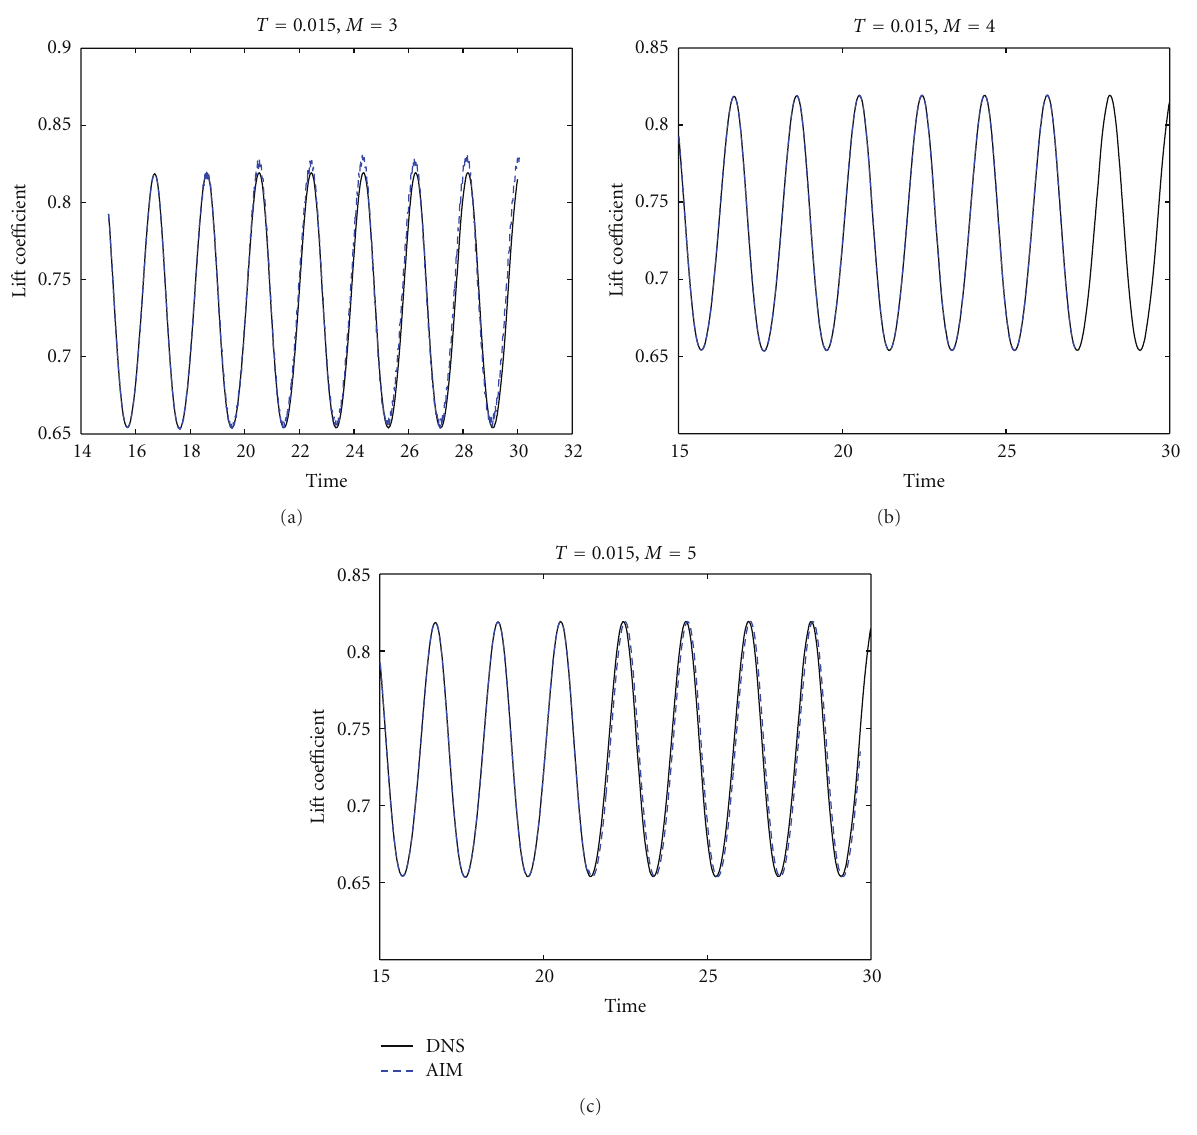
Figure 9: Periodic case: Re = 400. Computed lift coe ffi cient for T = 0 . 015 with various number of M . From top to bottom: M = 3,4, and 5.